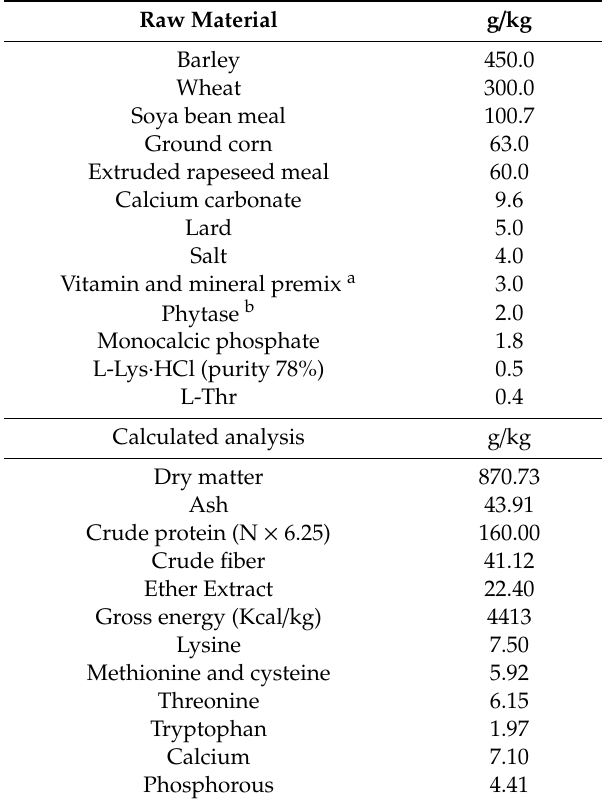
Table 1. Diet composition and chemical analysis of the experimental diet (as-fed basis; g /